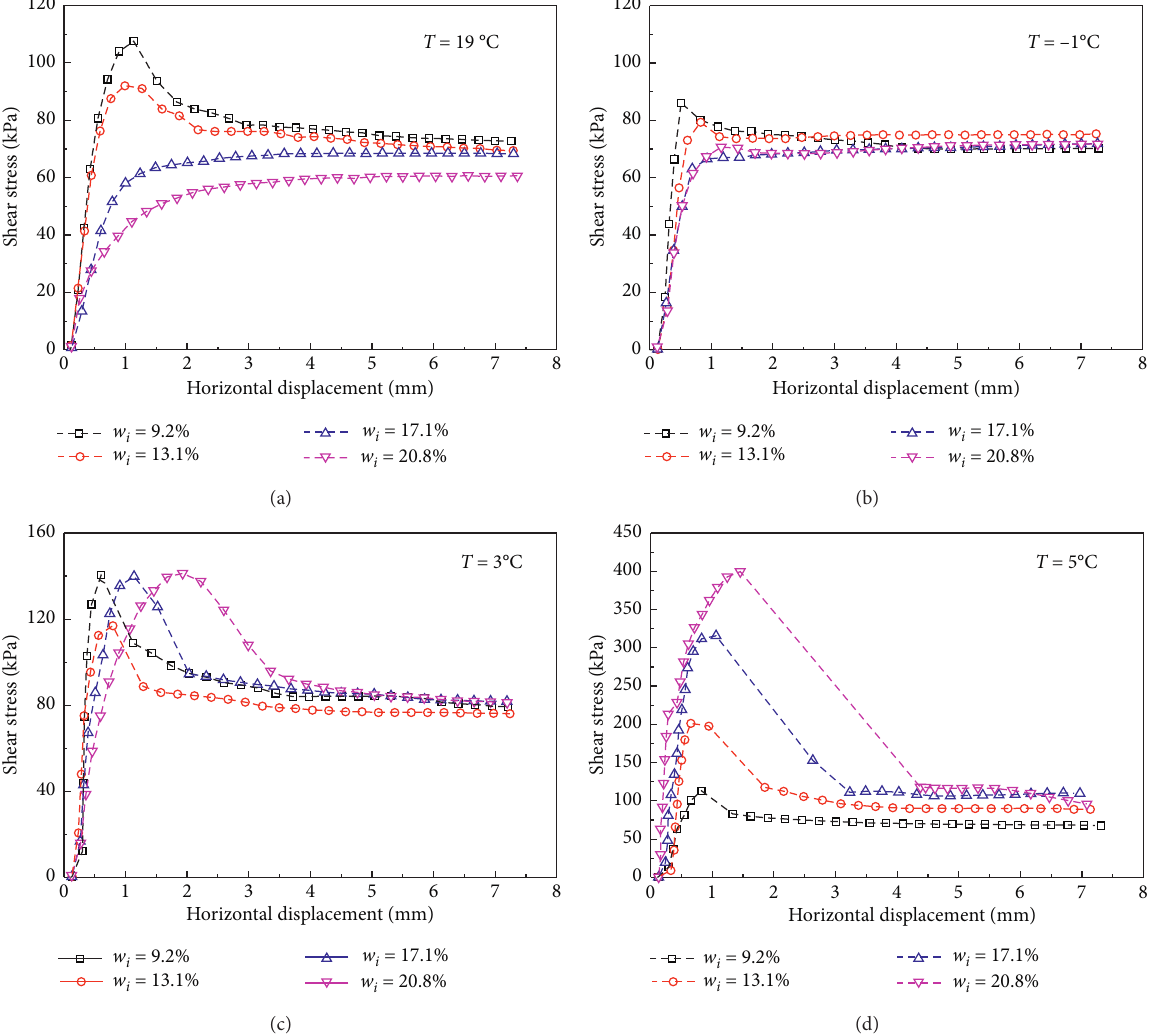
Figure 3: Shear stress versus horizontal displacement at the normal stress of 100kPa. (a) (T) � 19 ° C, (b) (T) � –1 ° C, (c) (T) � –3 ° C, and (d) (T) � –5 °